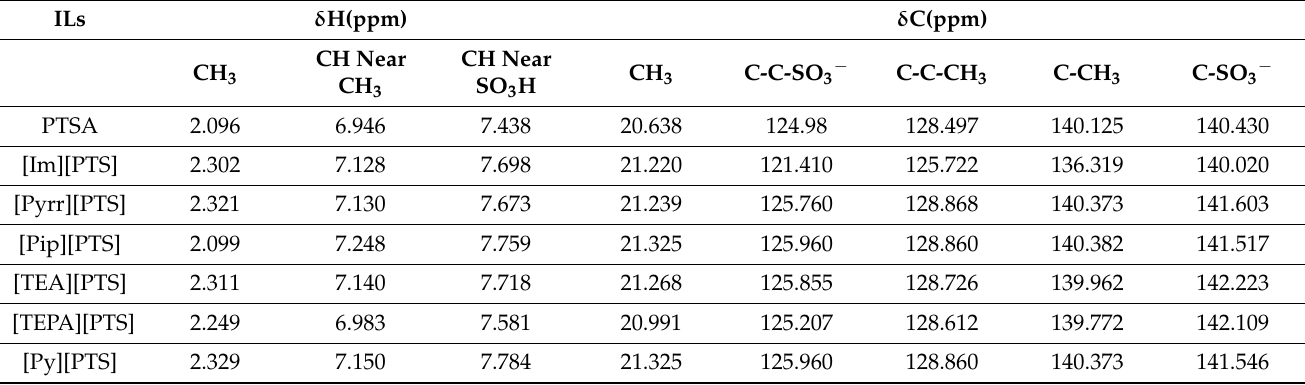
Figure 2. ( A ) 1 H NMR spectra of PTSA and the synthesized protic ionic liquids. ( B ) 13 C NMR spectra of PTSA and the synthesized protic ionic liquids. Table 1. 1 H NMR and 13 C NMR chemical shifts of PTSA with the different cations in CDCl 3